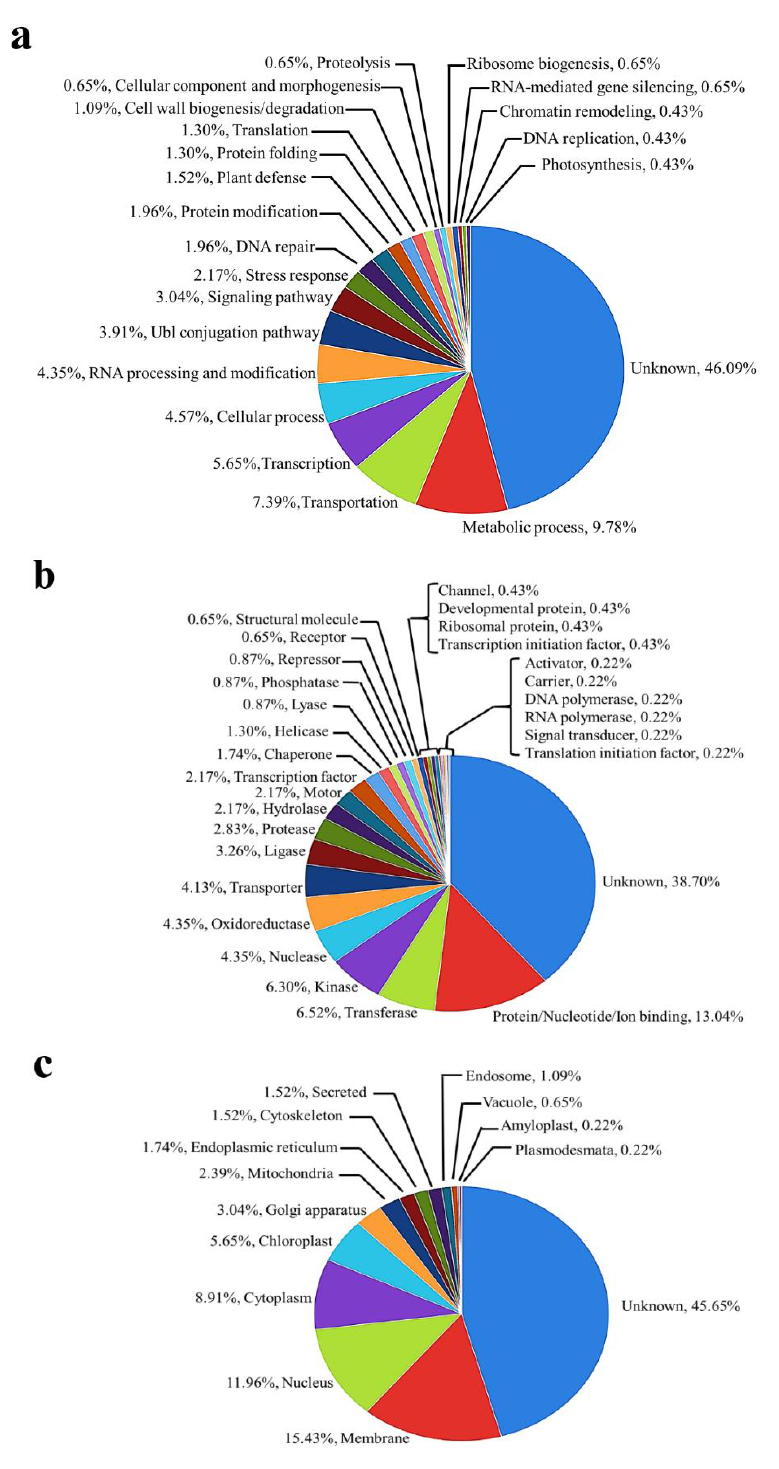
Figure 3. Biological function and subcellular localization of 460 identified phosphoproteins during somatic acquisition and plant regeneration. ( a ) Assignment of the 460 identified phosphoproteins to biological process categories with the use of gene ontology (GO) classification. ( b ) Assignment of the 460 identified phosphoproteins to molecular function categories with the use of GO classification. ( c ) Assignment of the 460 identified phosphoproteins to subcellular localization categories with the use of GO